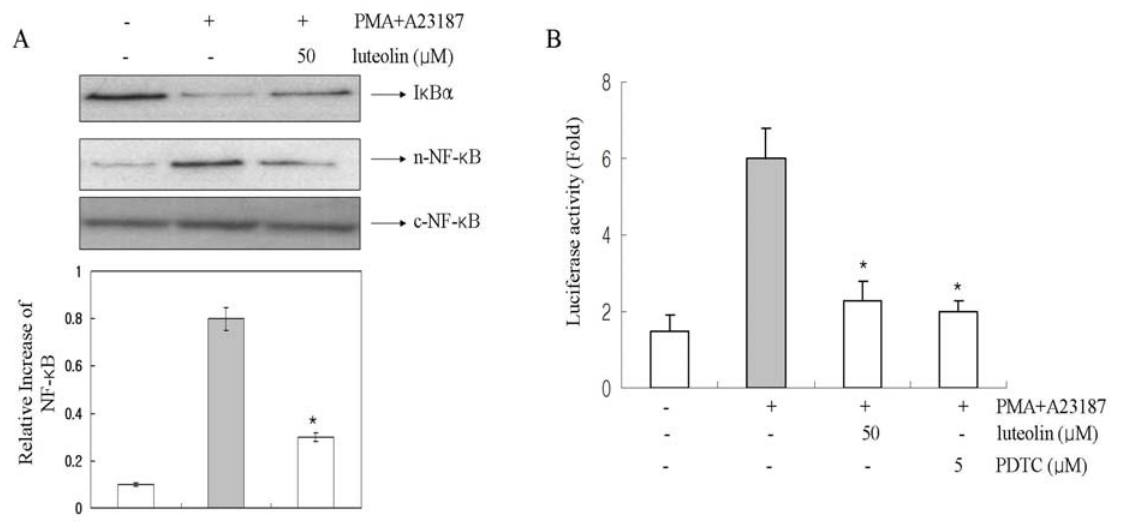
Figure 6. Effect of luteolin on the activation of NF- κ B in HMC-1 cells.